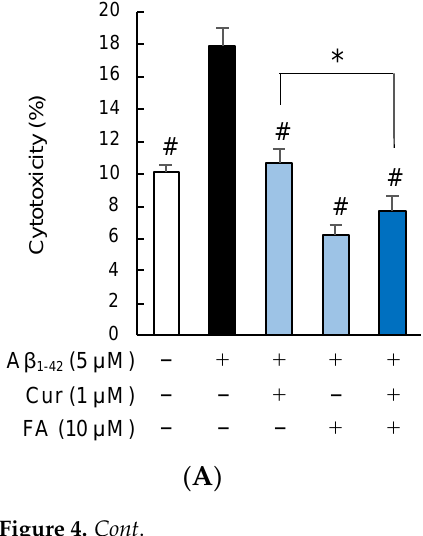
FA ( p = 0 .0461 vs. 1 μM Cur) significantly reduced cytotoxicity levels compared to treat-